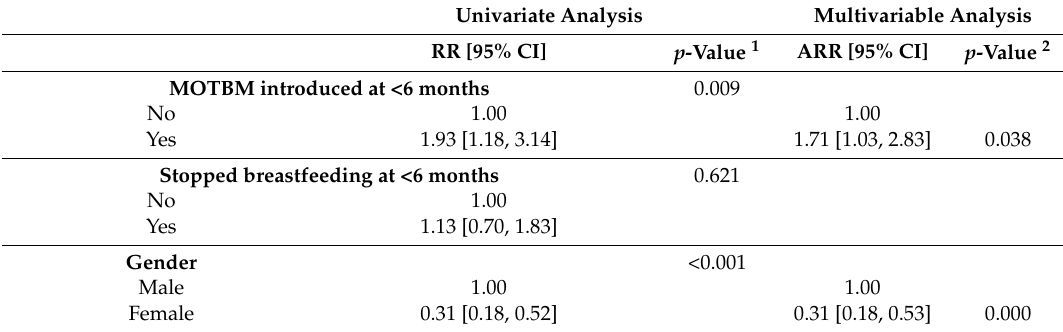
Table 3. Univariate and multivariable Logistic regression modeling the likelihood of medically-diagnosed persistent